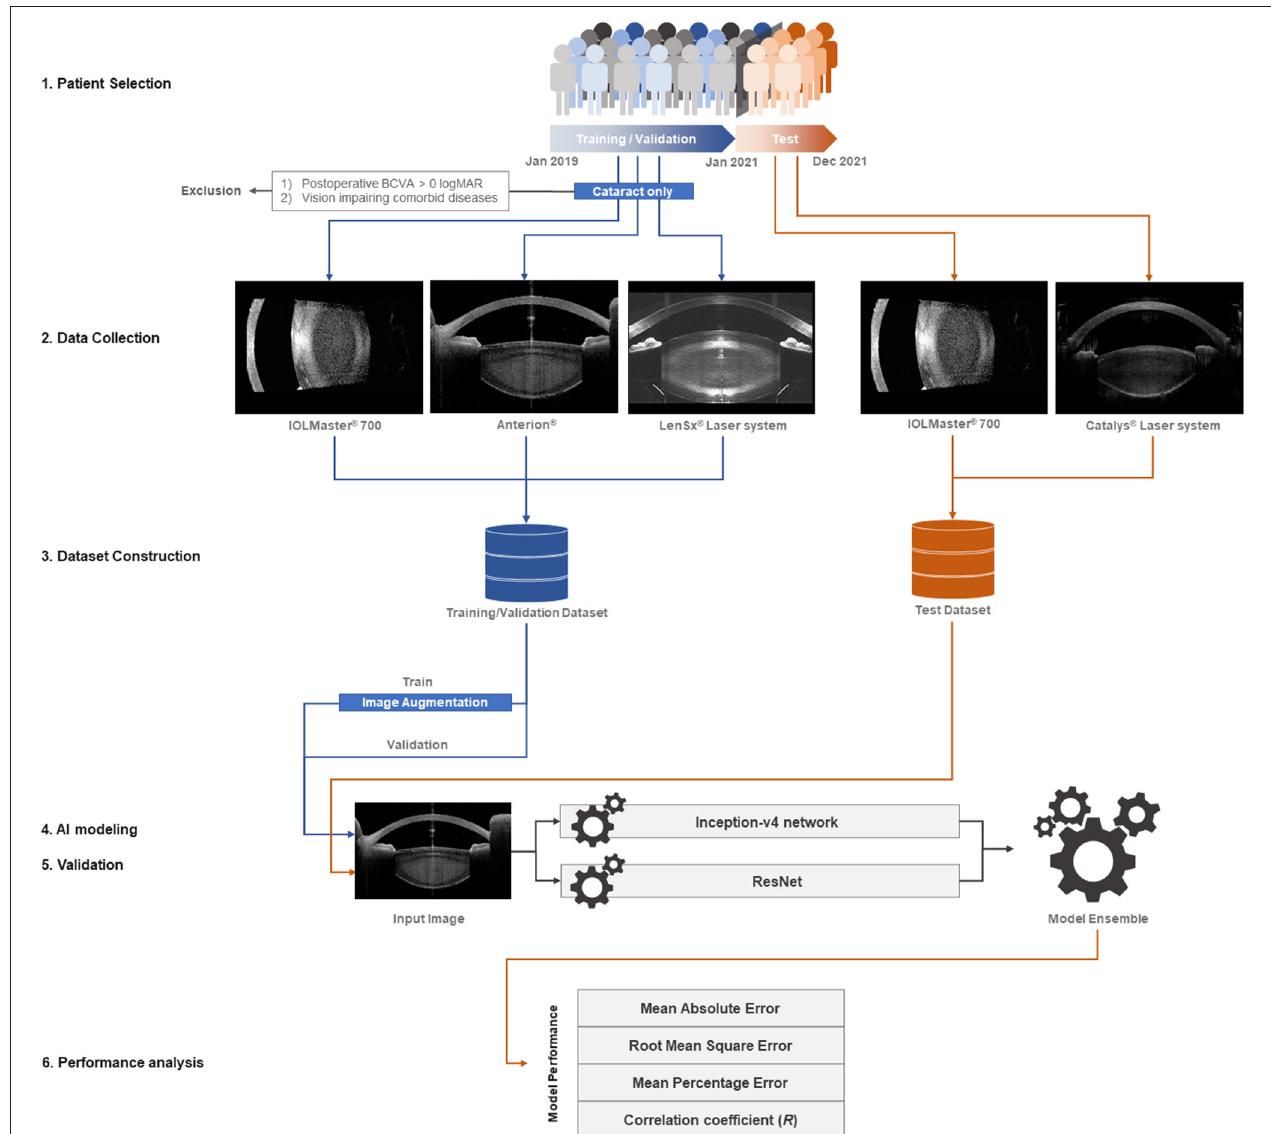
FIGURE 1 | Study flow diagram. For the training/validation dataset, we collected 2,332 anterior segment OCT images of 2,332 eyes in as many patients with isolated senile cataract, whose 1-month postoperative best-corrected visual acuity (BCVA) was 0.0 logMAR or better. The images were obtained between January 2019 and December 2020 using swept-source OCT (ANTERION ® ), optical biometry for intraocular lens calculation (IOLMaster ® 700), and a femtosecond laser platform (LenSx ® Laser System). With this process, we aimed to develop a pure cataract analyzer. For the test dataset, we collected 1,002 anterior segment OCT images